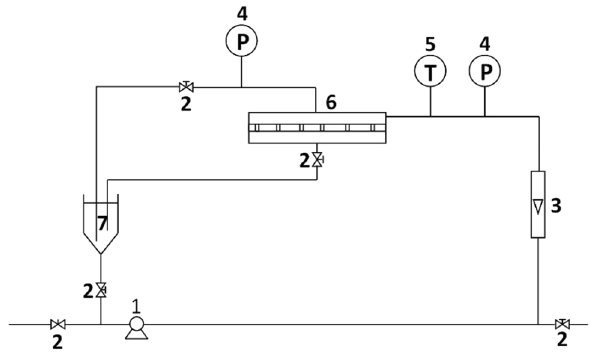
Fig. 7 Schematic diagram of cross-flow filtration experimental equip- ment. 1—centrifugal pump, 2—valves, 3—rotameter, 4—pressure gauge, 5—temperature gauge, 6—plate ceramic membrane module, 7—stock